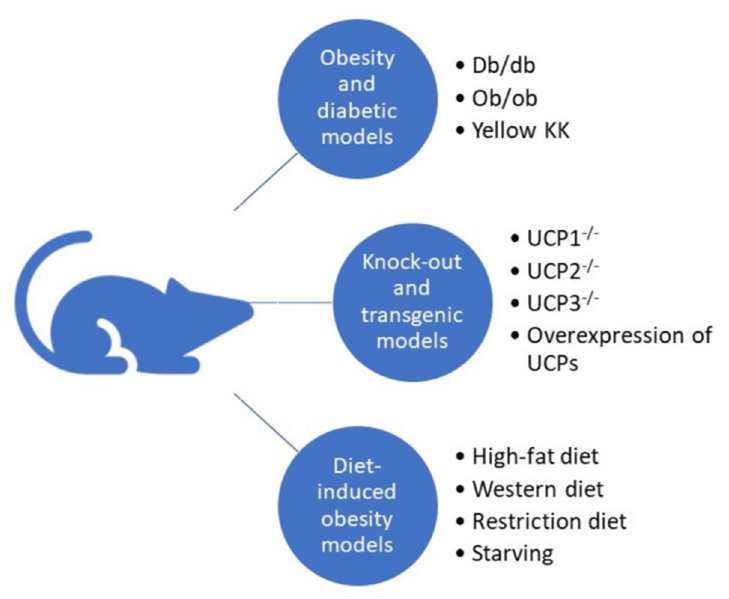
Figure 3. Different mouse models enable research on UCP’s roles in insulin sensitivity, diabetes, and and obesity.